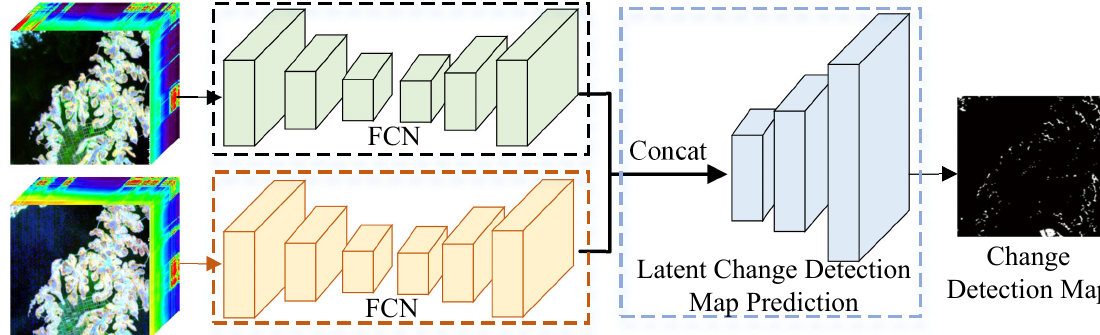
Figure 3. Architecture of the feature-level